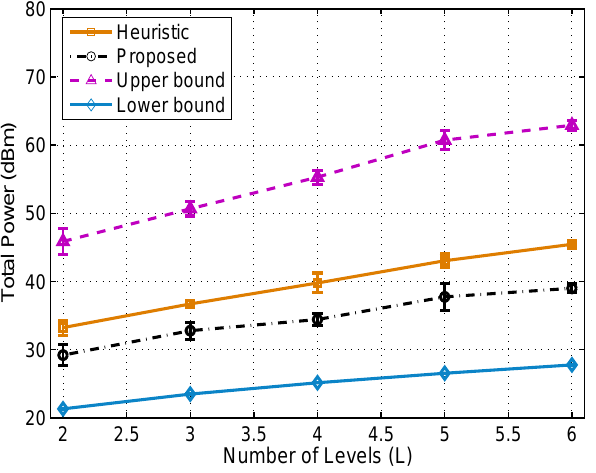
Figure 5. Total power vs. number of packet